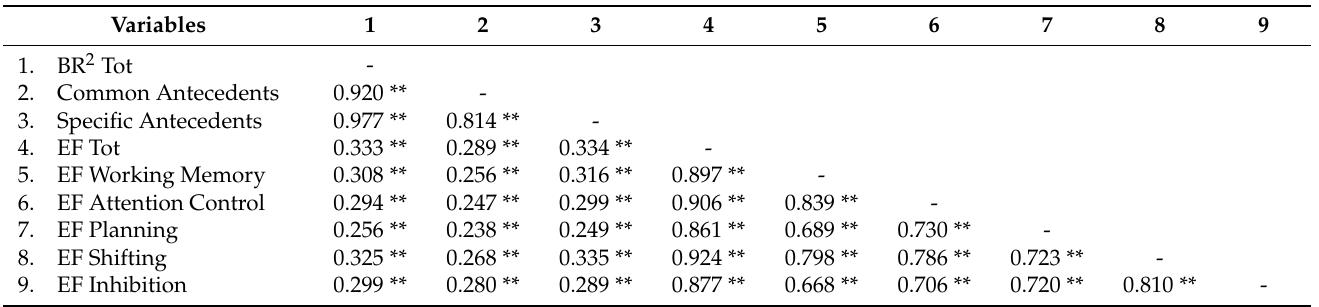
Table 13. Correlation between BR2 and EF variables.